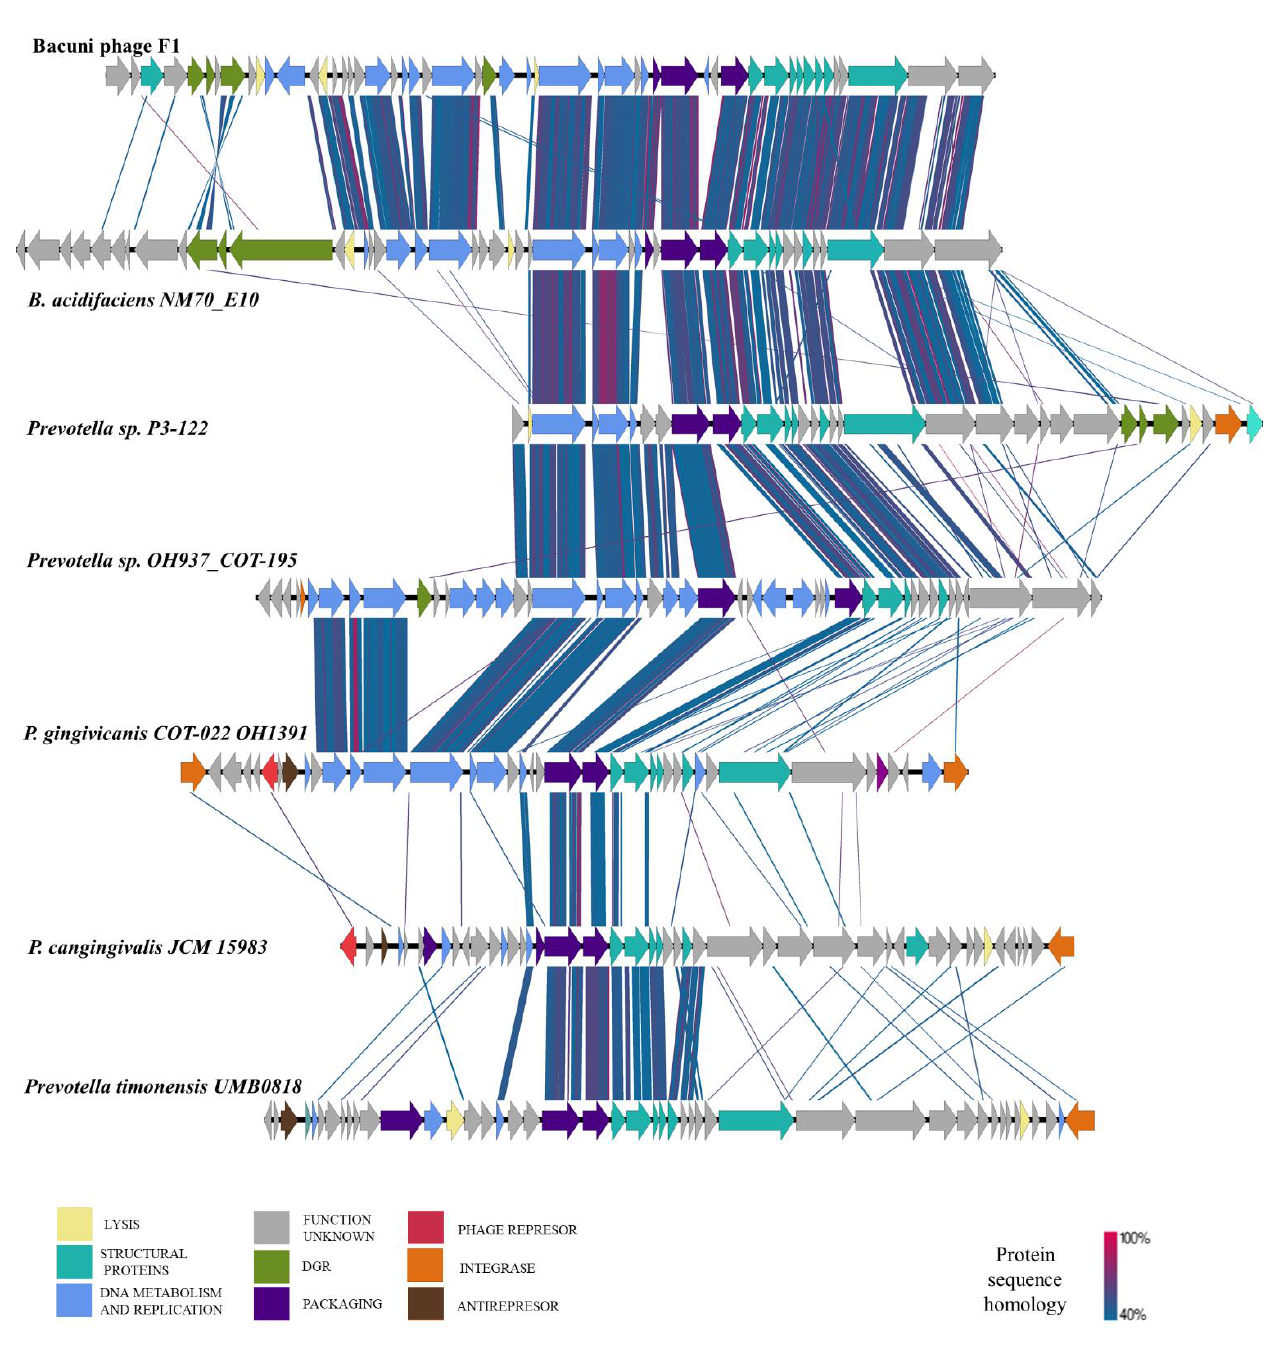
Figure 4. Comparison of genome organization and genomic synteny of Bacuni phages to putative prophage genomes in various bacterial hosts from Bacteroidales . BLASTp sequence homology (40% similarity and higer) between Bacuni phage Figure 1. and related prophage regions identified in genomes of B. acidifaciens, Prevotella sp., P. gingivicanis and P. cangingivalis (see Table 2 for more information) is indicated with a color link. Colors of putative proteins correspond to the general predicted functions (see color legend).